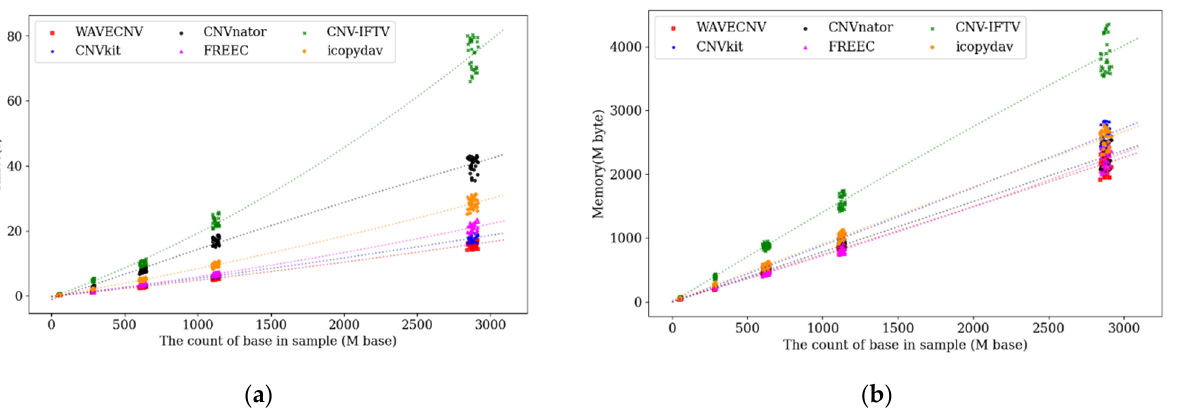
Figure 4. The figure shows the time and memory used by the six methods to call CNVs in the simulated data with the coverage of 8 × . ( a ) The trend of algorithm calculation time with the count of bases in a sample. ( b ) Relationship between the size of memory and the count of bases in a